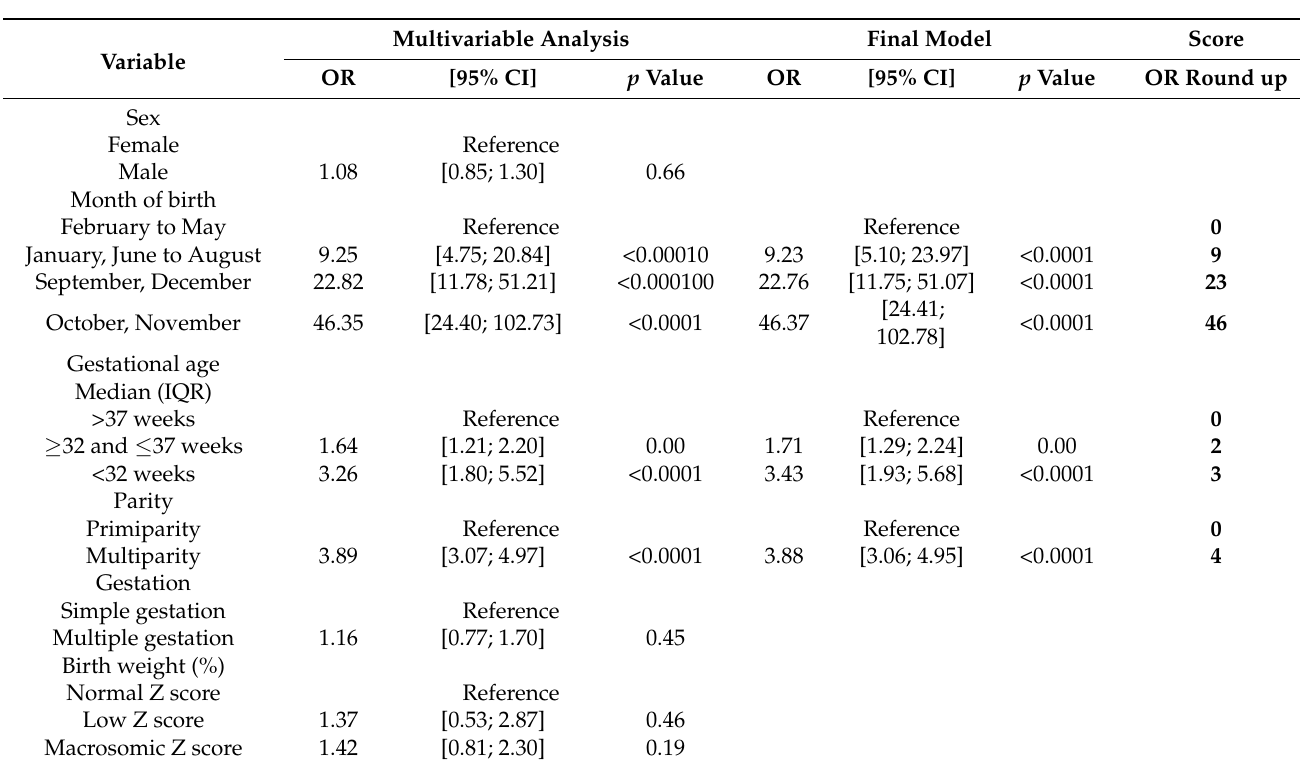
Table 2. Multivariate analysis of the risk factors for RSV-associated hospitalisation during the first 6 months of life and predictive